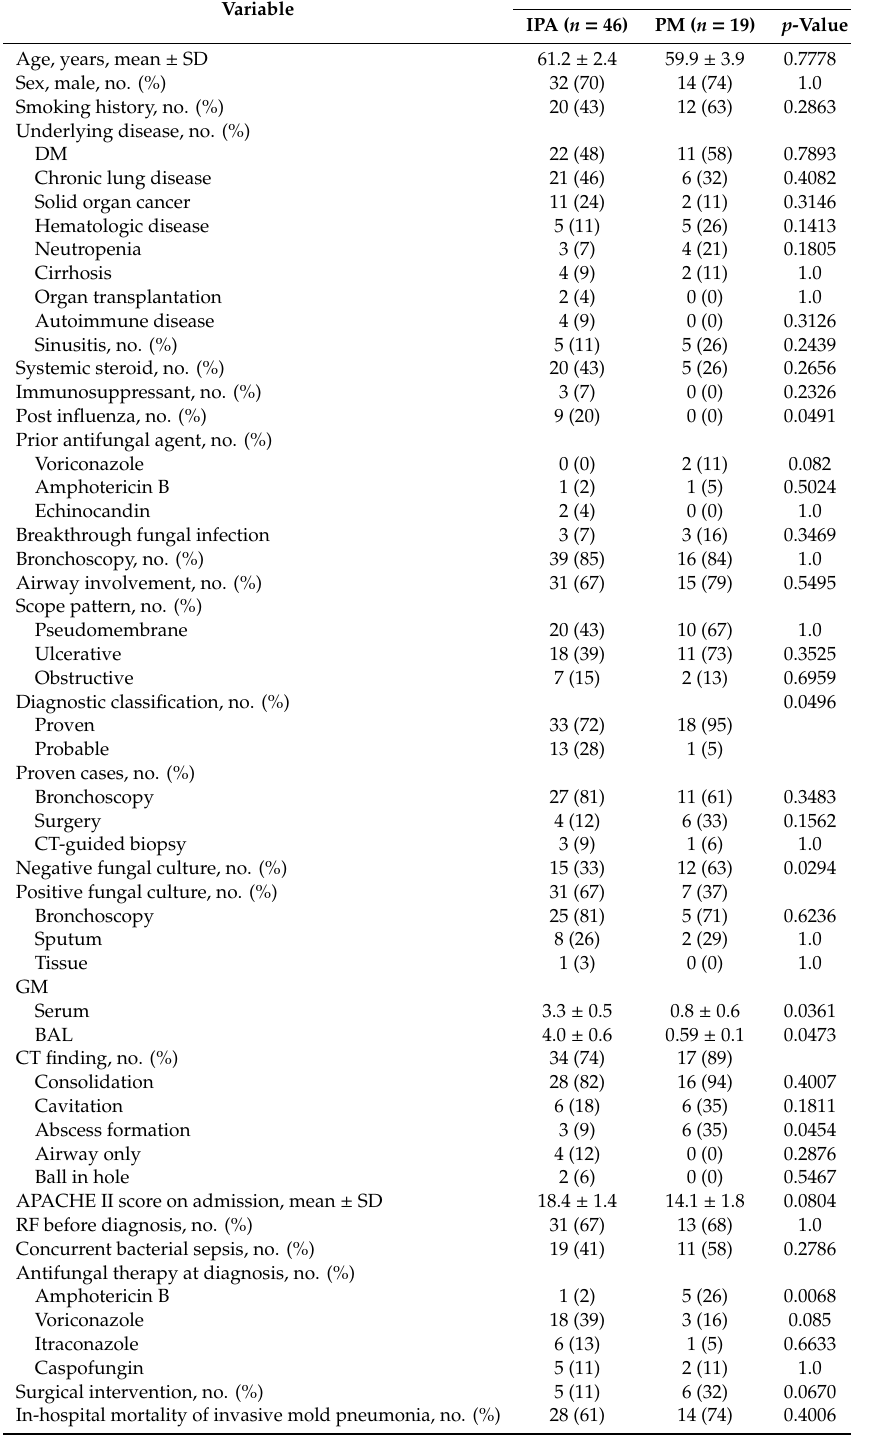
Table 1. Comparison of clinical characteristics, treatments, and outcomes between IPA and